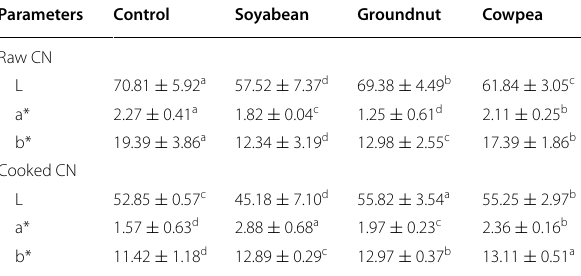
abcd Means in the same row with varying superscripts are ( P < 0.05), CN Chicken Nuggets